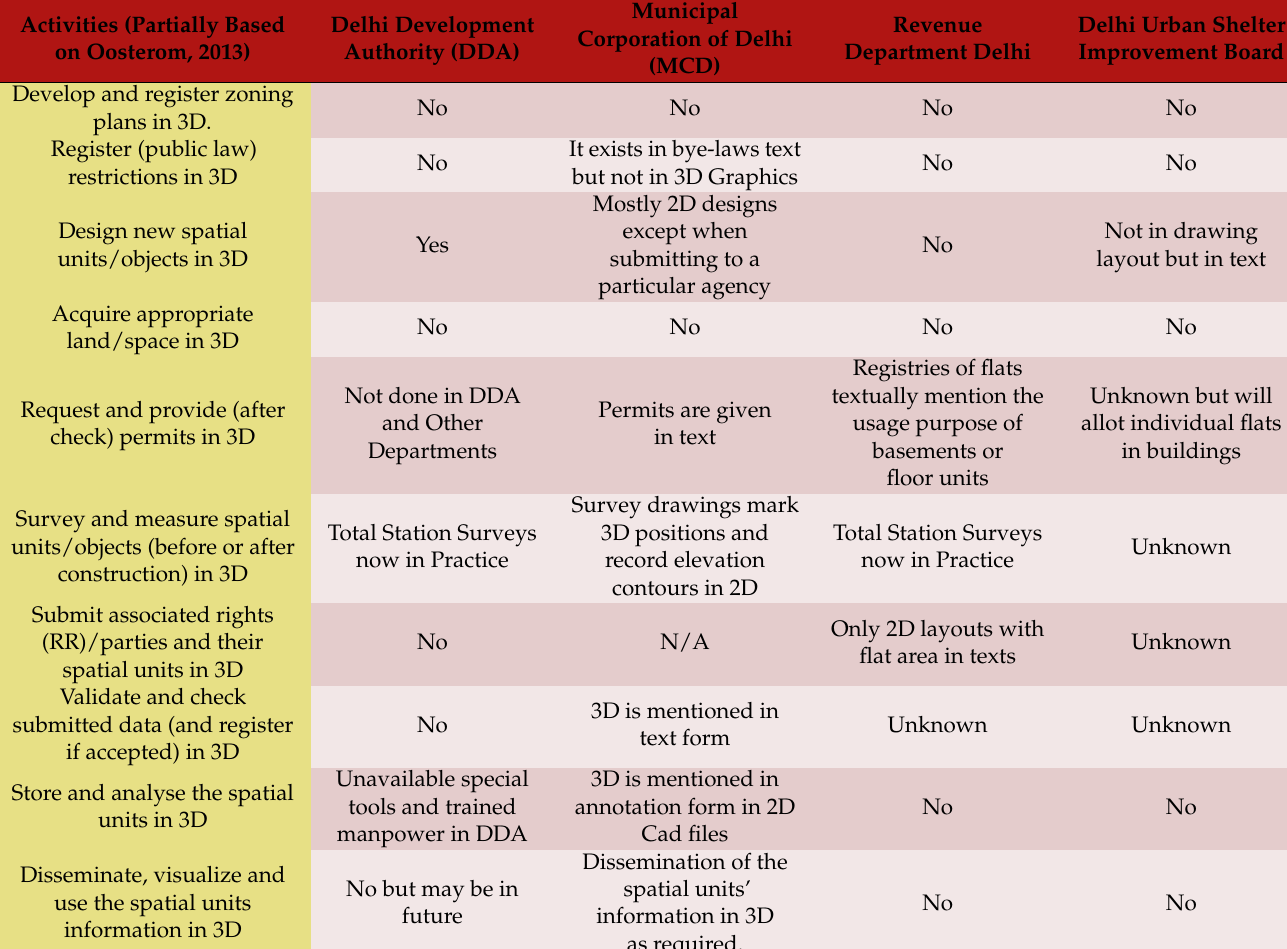
Table 1. Current practices for 3D by land agencies in Delhi, India; Source: